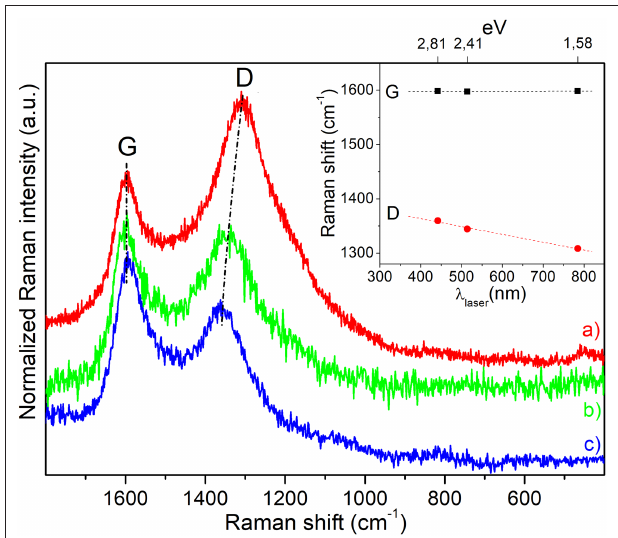
FIGURE 6 | Raman spectra of magnetic carbon microspheres obtained by means of three different exciting laser lines: (a) λ = 785nm, (b) λ = 514nm, and (c) λ = 442nm, respectively. Spectra have been normalized to the G-band and shifted for a better comparison. In the inset the laser energy dependence of D- and G-band positions is